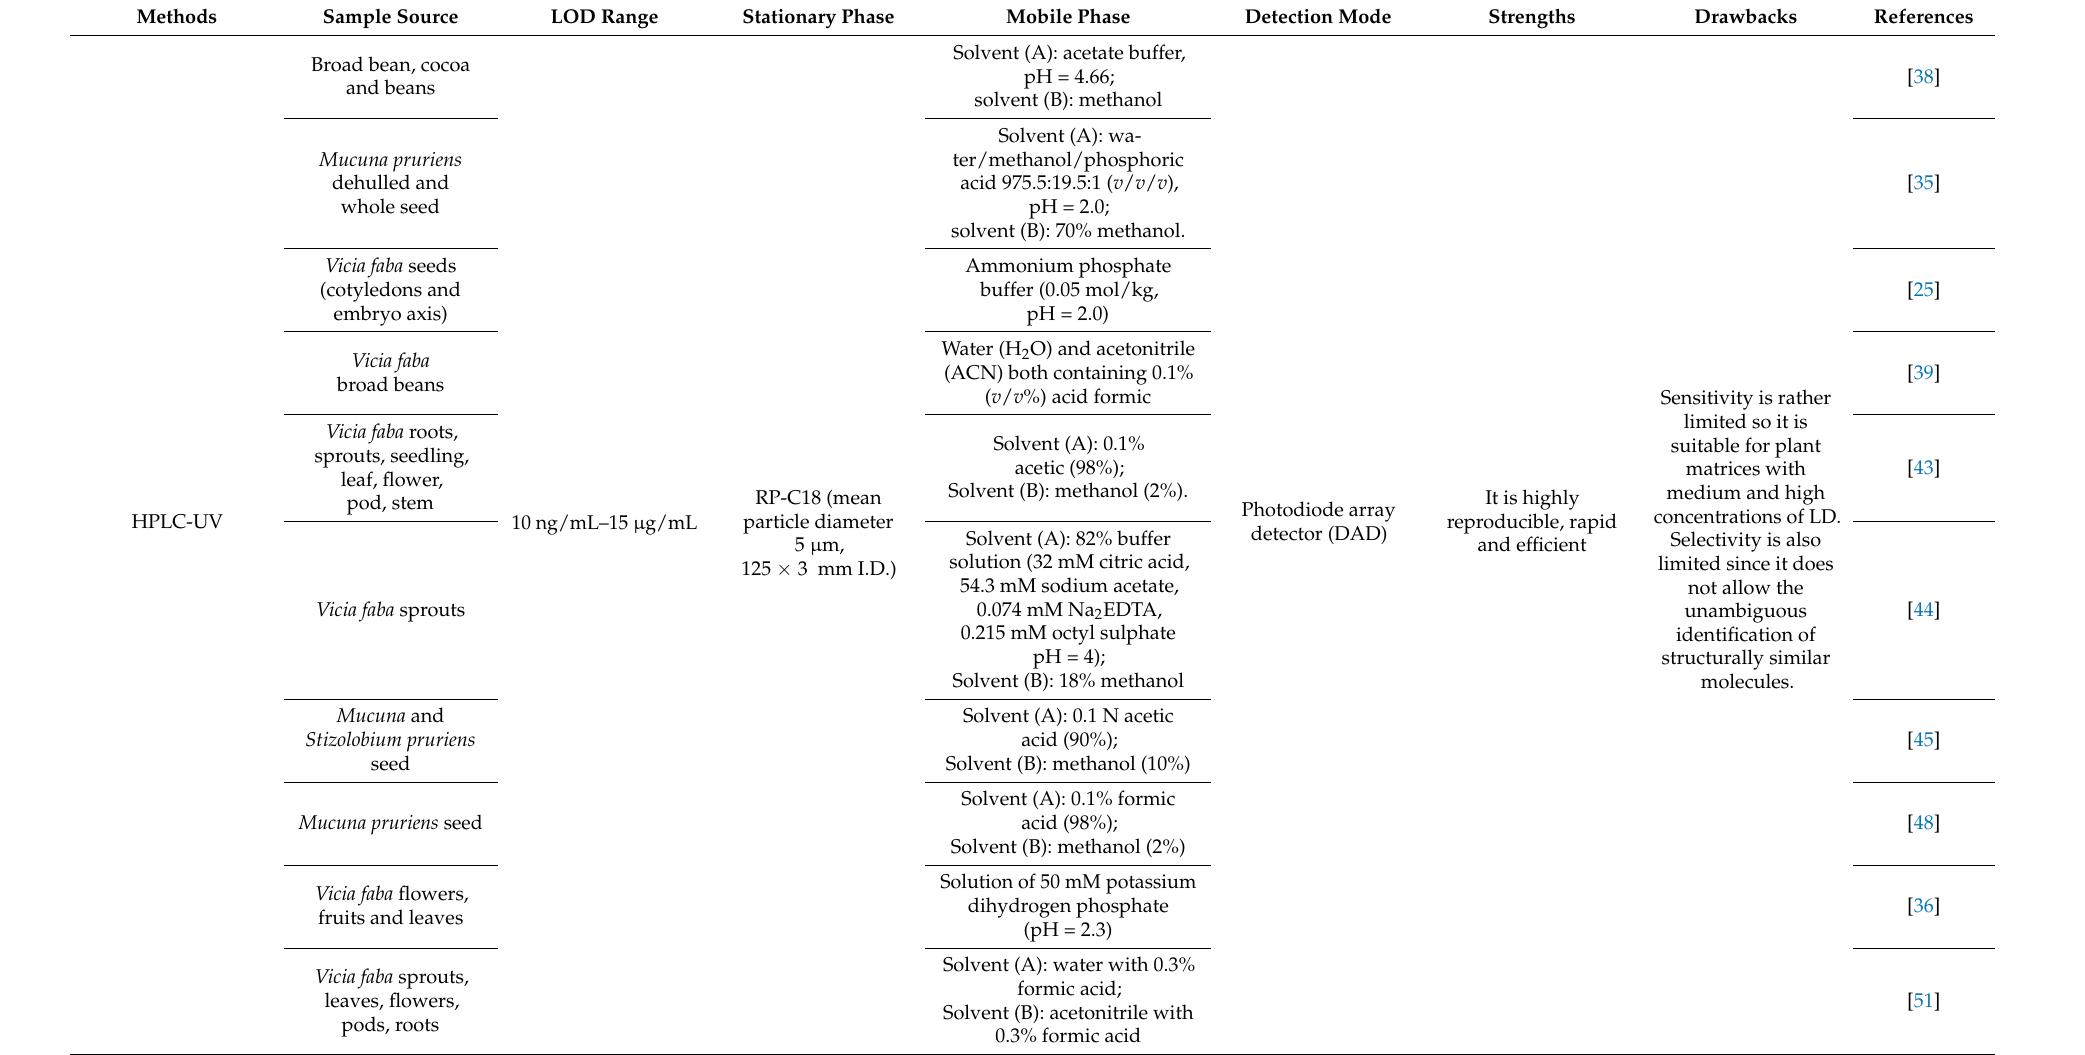
Table 2. Analytical methods and operation conditions employed in the last twenty years for the LD detection with their main strengths and